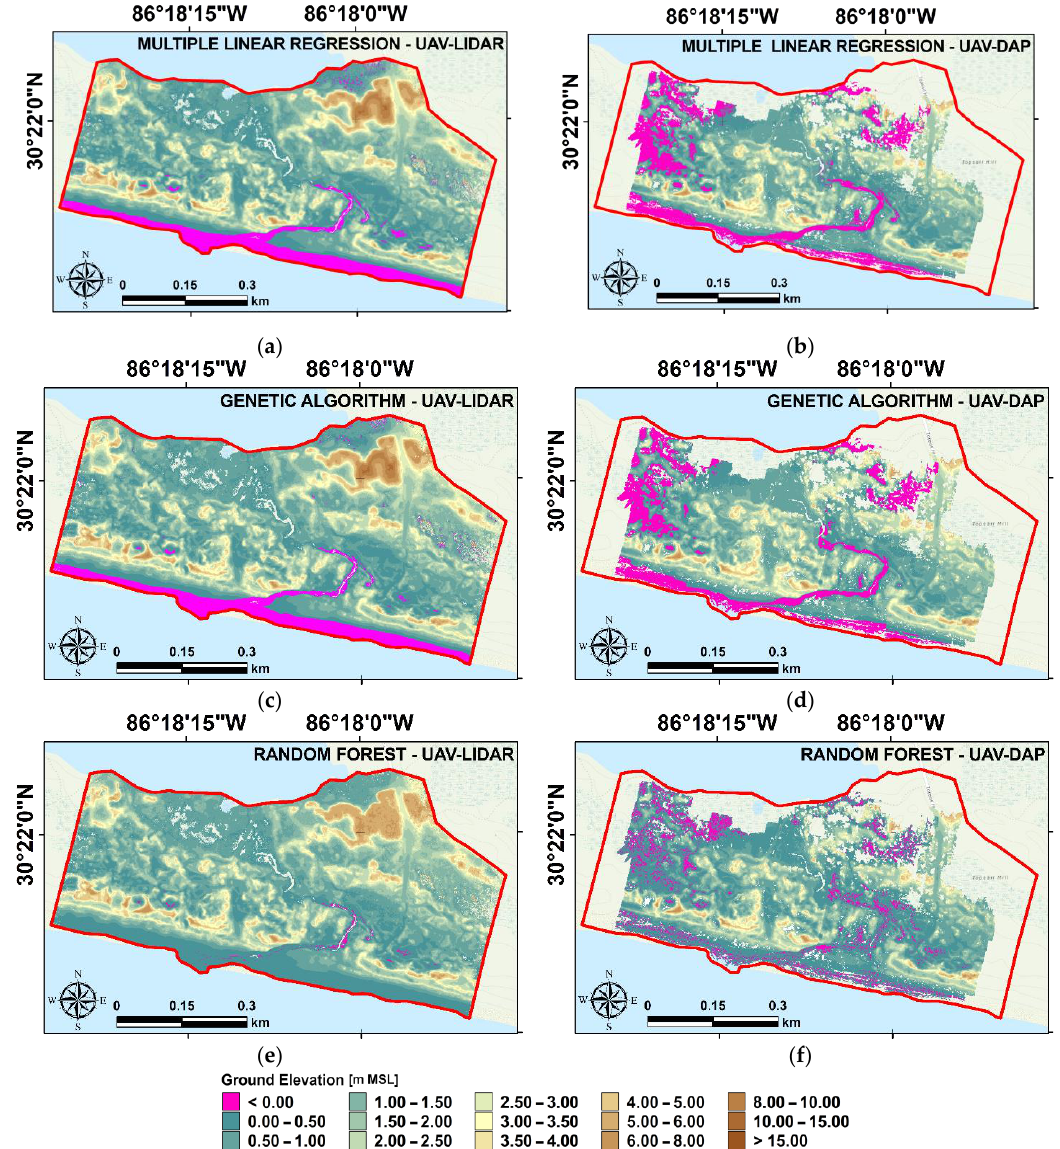
Figure 5. Maps of the ground elevation obtained by applying the multiple linear regression ( a , b ), the genetic algorithm ( c , d ), and the random forest ( e , f ) methods to the UAV – LIDAR point cloud, transformed using the regression plane method (first column), and the non-transformed UAV – DAP point cloud (second column). The background of the images in the first rows is the USGS national map.